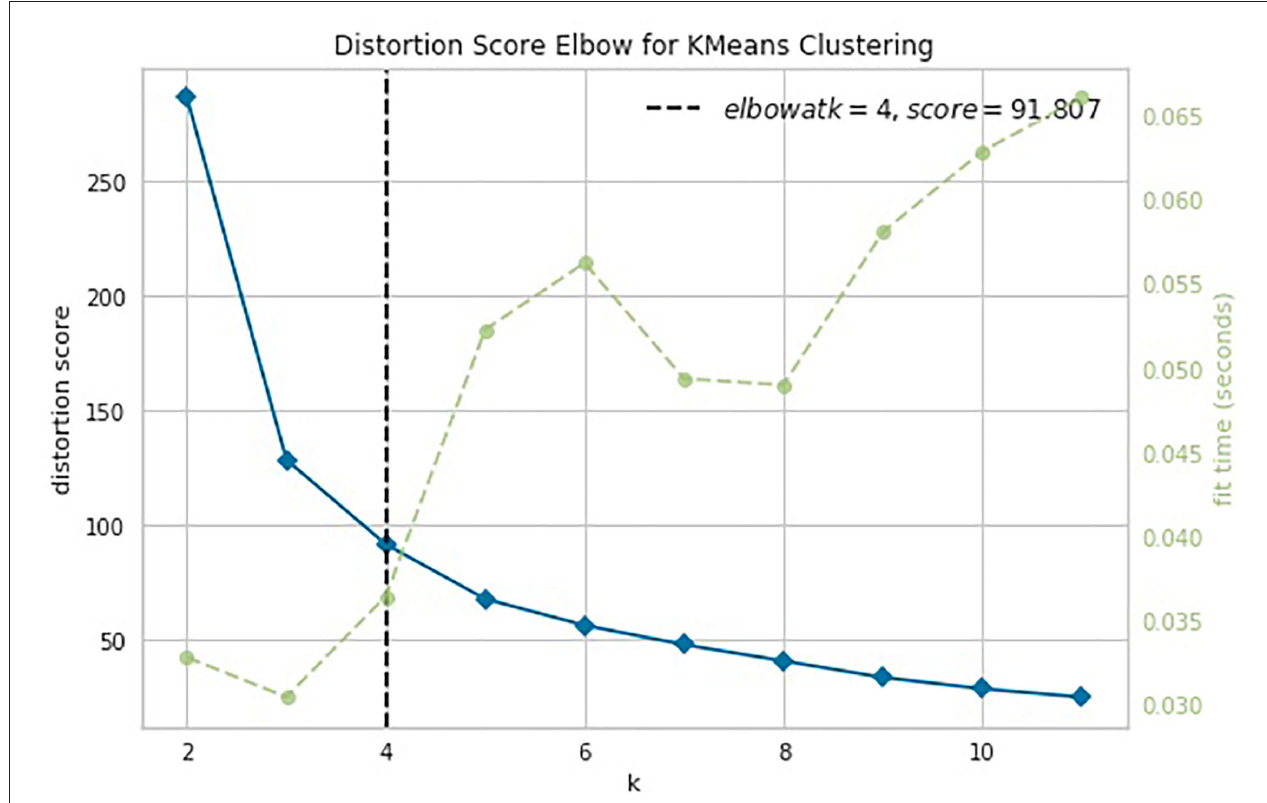
FIGURE 5 | Selection of the optimal number of clusters by using the Elbow method with the knee point detection algorithm for ISCA